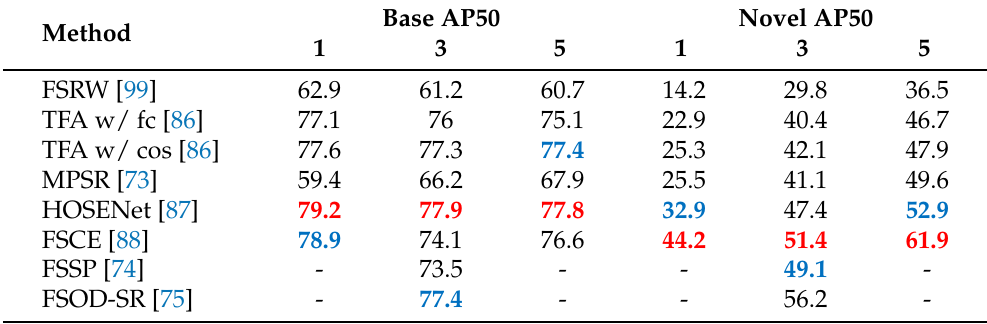
Table A5. Base-forgetting comparisons on PASCAL VOC Novel set 1 . Before fine-tuning, the base AP50 in base training is 80.8. Red, and blue indicate the state-of-the-art and the second-best,